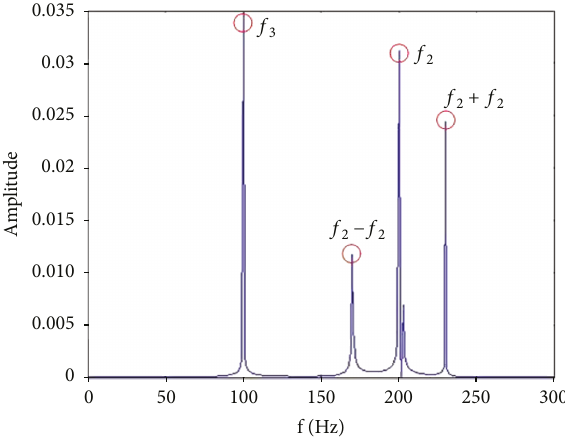
Figure 7: The result provided by the proposed method.